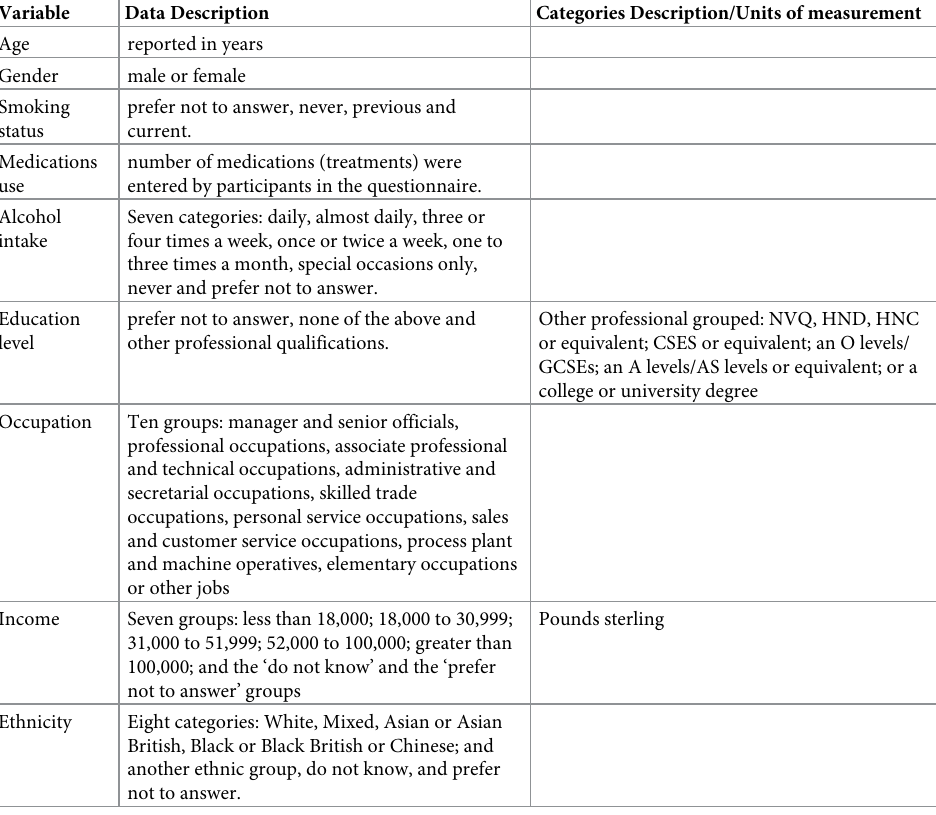
Table 1. Baseline participant